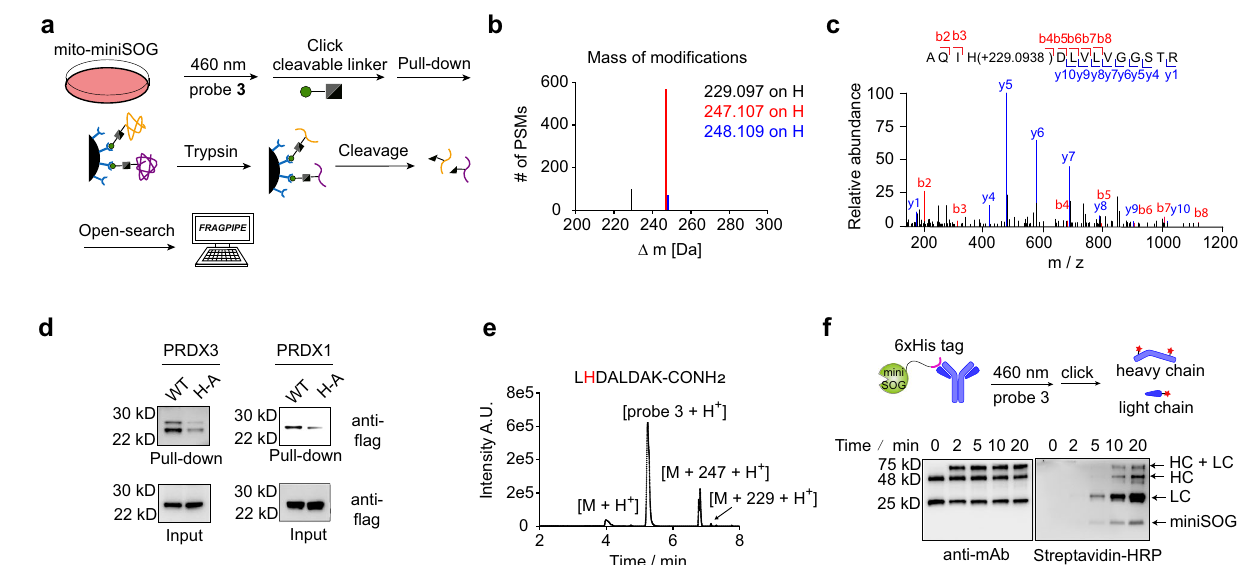
Fig. 2 | Characterization of PDPL labeling sites and validation of labeling in vitro. a Anunbiased work fl ow to study residue selectivity using the MSFragger- based FragPipe computational platform. A cleavable linker was used for Click chemistry, which enables the photo-cleavage of the modi fi ed peptide from the streptavidin resin. An open search was deployed to identify the masses of mod- i fi cation as well as the corresponding residues. b The masses of modi fi cation that occur proteome-wide are assigned. PSMs peptide spectrum matches. c MS2 spectrum annotation of a probe 3 -modi fi ed histidine site. Covalent reaction with probe 3 adds +229.0938Da to the modi fi ed amino acid as a representative example. d Mutation assay to validate PDPL labeling. PRDX3(H155A, H225A) and